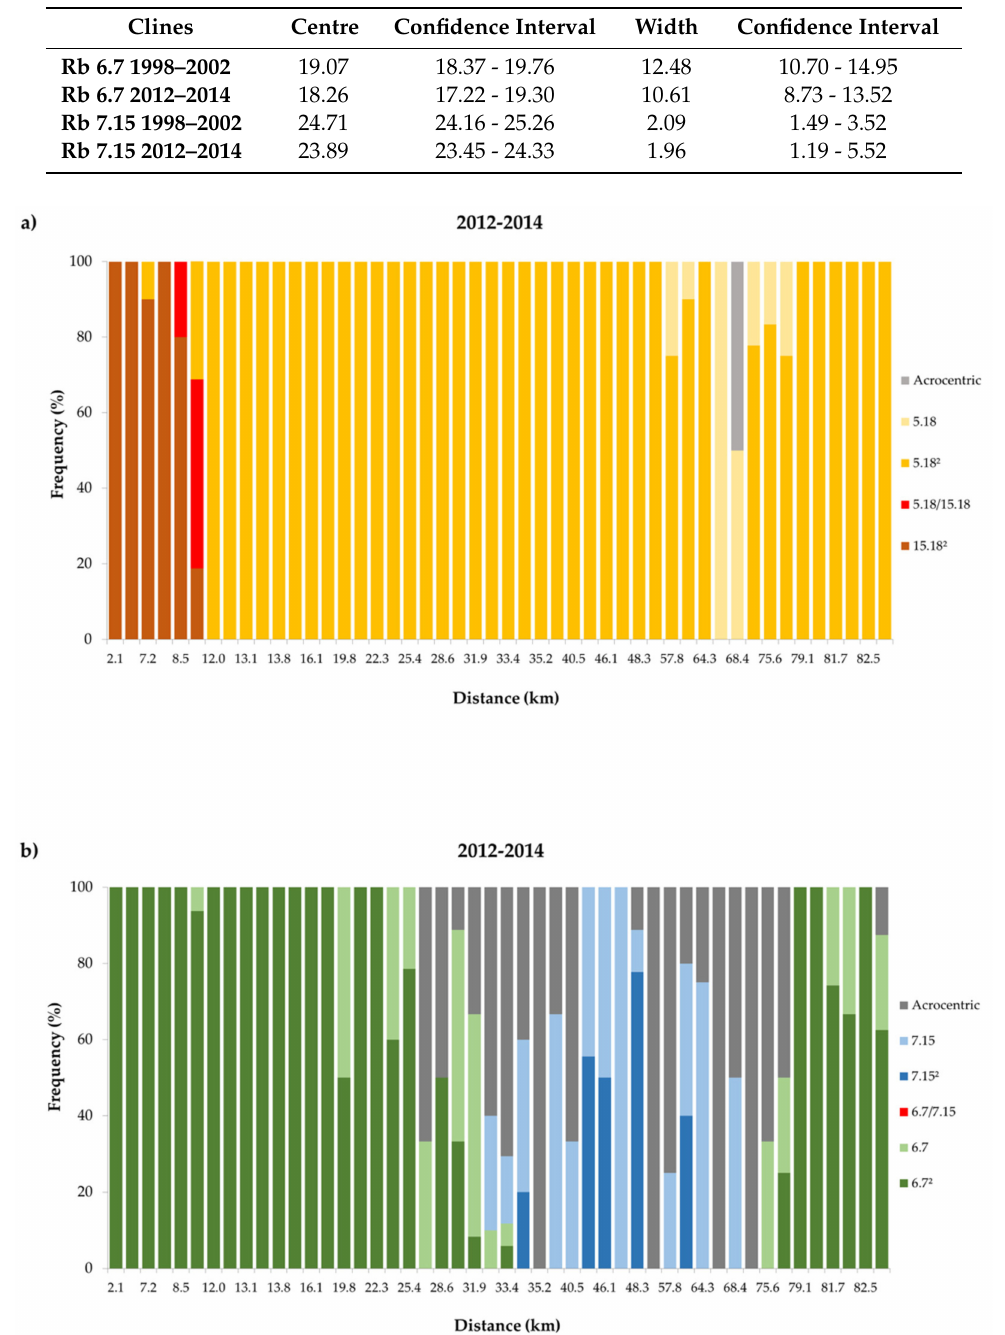
Figure 2. Frequency of diagnostic Rb fusions for the period 2012-2014. a) the upper panel shows frequencies of fusions Rb (15.18) and Rb (5.18) in homozygous [(15.18) 2 ; (5.18) 2 ] and heterozygous [(5.18)] state, frequency of hybrid mice carrying both fusions [(5.18) / (15.18)] and frequencies of